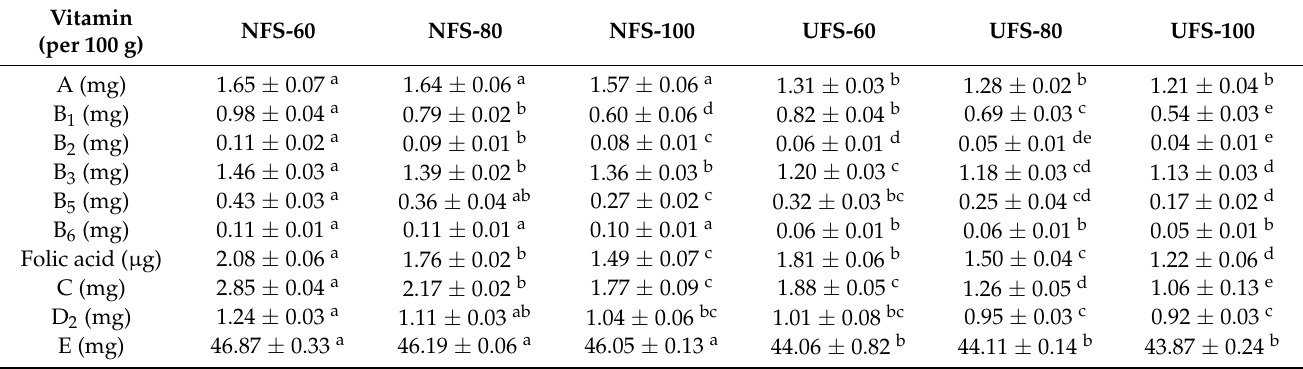
Table 2. Vitamin composition of palmyra palm syrups prepared by thermal process and ultrafiltration